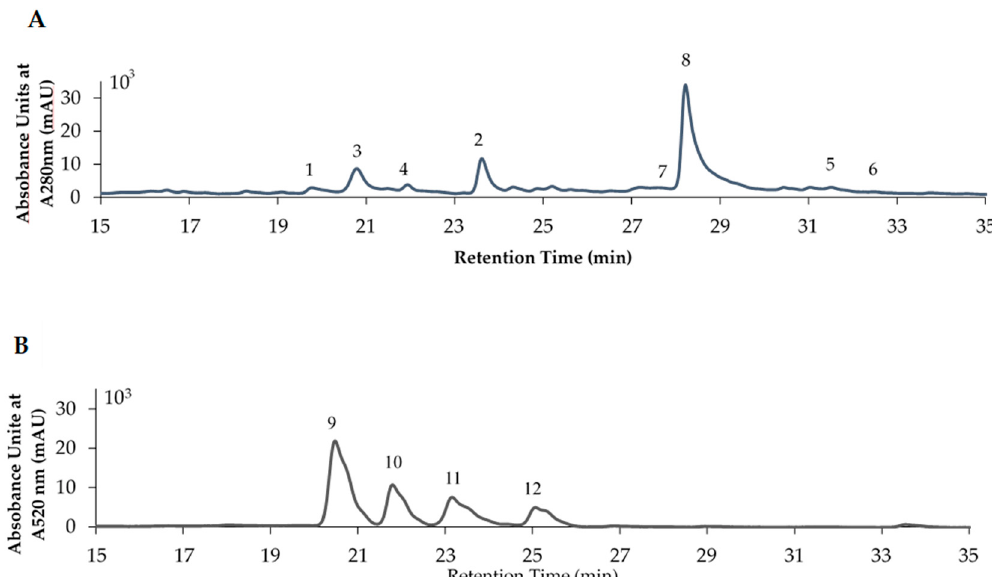
Figure 5. HPLC chromatogram of the raspberry fruit extract of S1. Peak number 1: (+)-Catechin (RT: 19.66 min, MS: 289 m/z ); 2 ( − )-Epicatechin (RT: 23.41 min, MS: 289 m/z ); 3: Procyanidin B4 (RT: 20.78 min, MS: 577 m/z ); 4: Flavan-3-ol trimer (RT: 22.57 min, MS: 865 m/z ); 5: Quercetin (RT: 31.44 min, MS: 301 m/z ); 6: Quercetin-3-O-glucuronide (RT: 32.21 min, MS: 447 m/z ); 7: Lambertianin C (RT: 27.79 min); 8: Sanguiin H-6 (RT: 28.63 min, MS: 934 m/z ); 9: Cyanidin-3-O-sophoroside; 10: Cyanidin-3-O-sambubiside; 11: Cyanidin-3-O-glucoside; 12: Cyanidin-3-O-rutinoside. The structure of each compound is shown in Figure 1. ( A ) General conditions for polyphenol analysis. ( B ) Conditions for anthocyanin analysis. Table 3. Polyphenol contents (mg/100 mg of DW) in raspberry fruit extracts at various stages of maturation. Mg/ML (+)-catechin ( 1 )